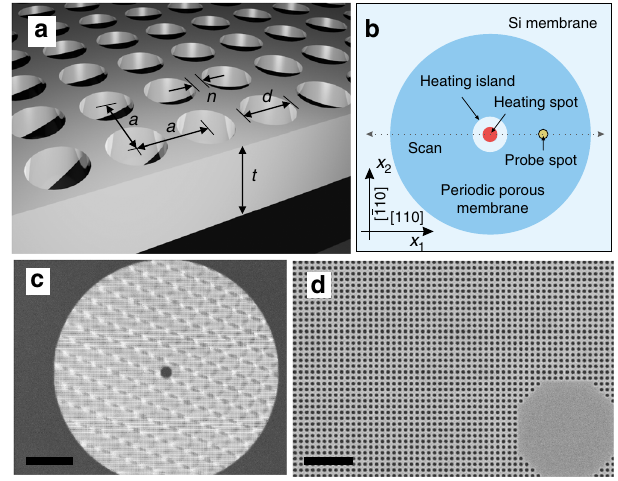
Fig. 1 Samples for two-laser Raman thermometry experiment. a Schematic picture of the periodic porous membrane — square lattice of cylindrical holes in the free-standing membrane, where t = 250 nm is the membrane thickness, d is the hole diameter, a is the lattice parameter and n stands for the neck. b Top view of the sample design depicting the temperature scan direction and crystallographic orientation. The porous area is enclosed by two circles with diameters of about 5 and 100 μ m. c , d Scanning electron microscope images of sample S2 ( a = 250 nm and d = 140 nm). Scale bars in c , d are 20 and 2 μ m,